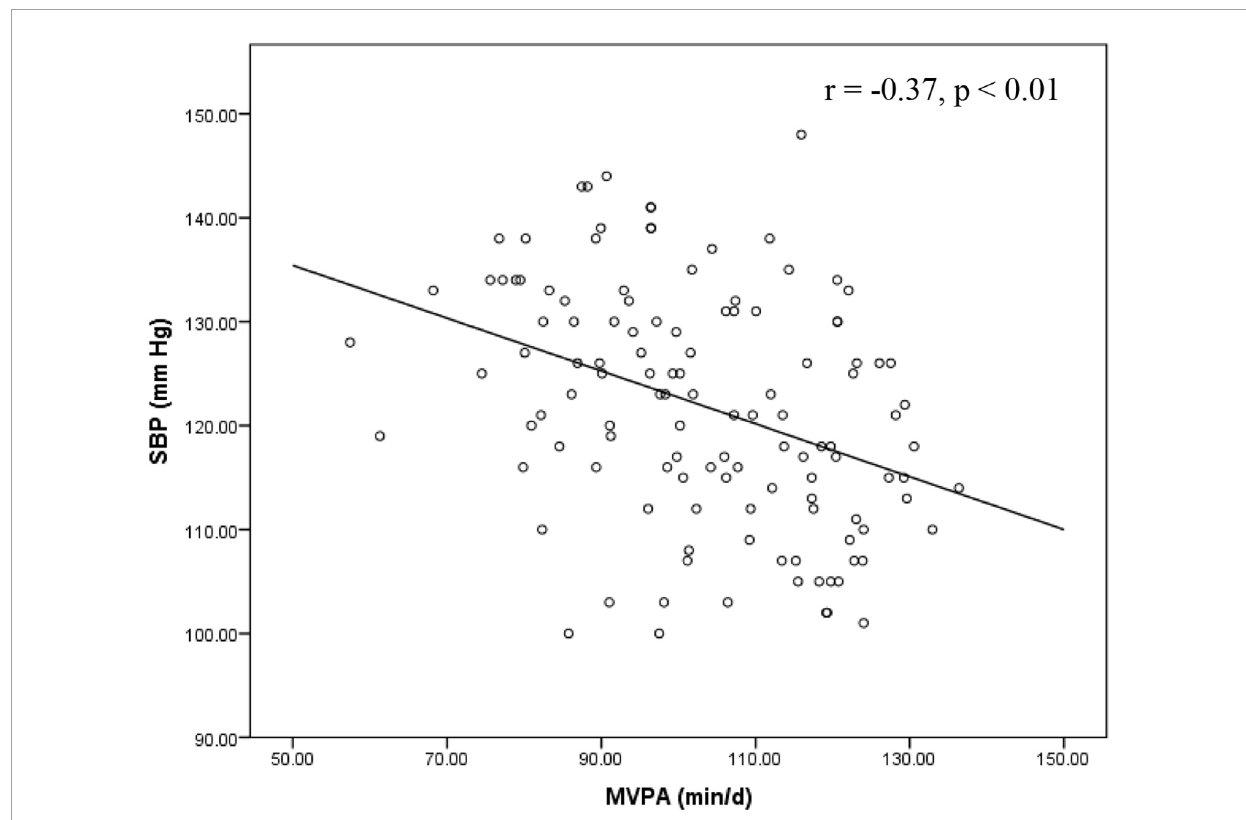
FIGURE3 Relationship between SBP and MVPA in the total sample. MVPA, moderate-to-vigorous intensity physical activity; SBP, systolic blood pressure.